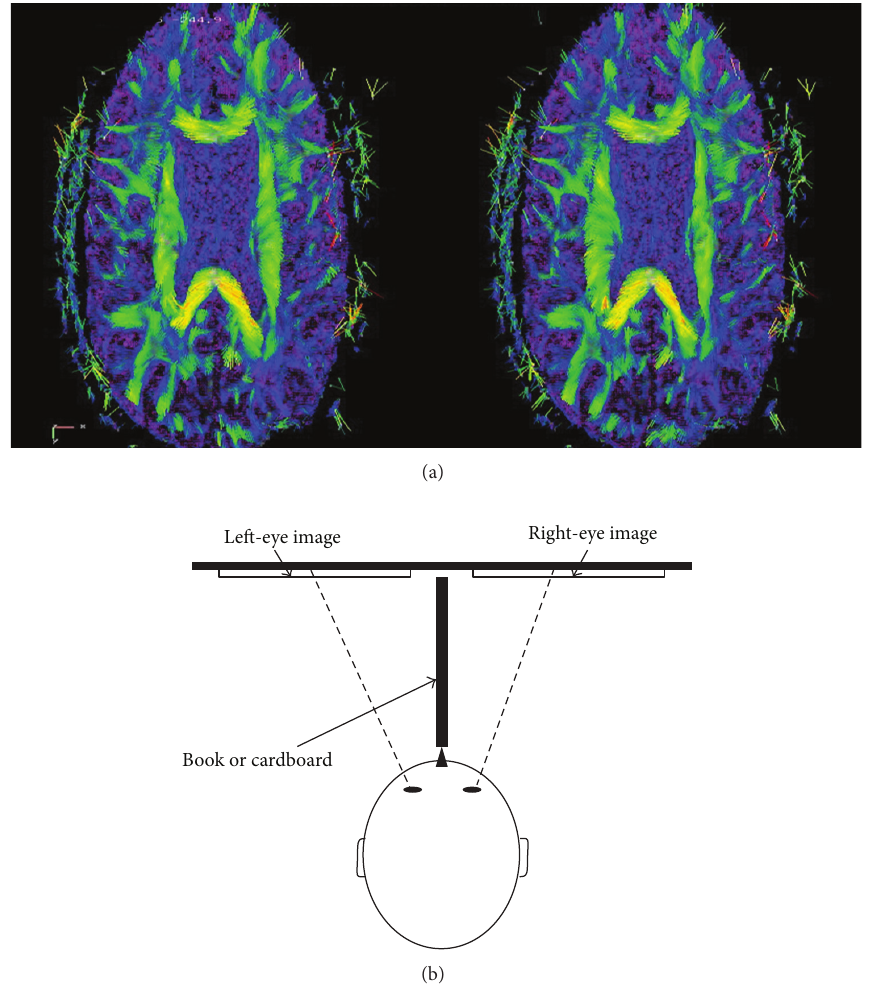
Figure 2: 3D visualization tool. Stereoscopic left- and right-eye-image generated by the visualization tool; one can achieve the stereo effect by focusing beyond the image plane or with the help of a stereoscope, or by using a piece of cardboard put between the two images (as shown schematically in (b) the top-down view) such that each eye is able to see only one of the two images. Once the stereo effect is achieved, one can clearly appreciate the 3D effect of the headless arrows pointing out of the paper plane at various